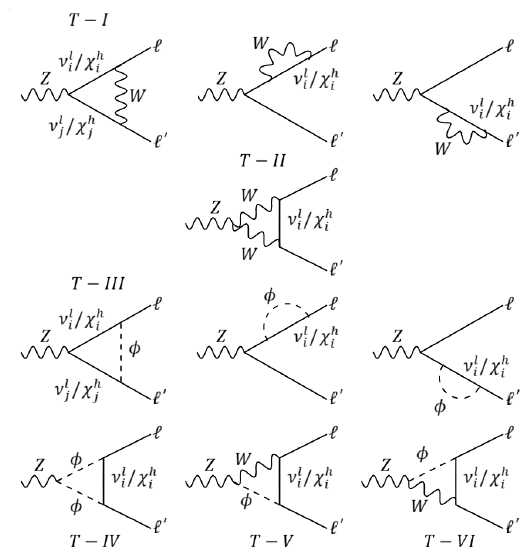
Figure 4 . Z penguins diagrams that contribute to the decay. Diagrams T − I and T − III allow to mix light ( ν l ) and heavy Majorana neutrinos ( χ h i